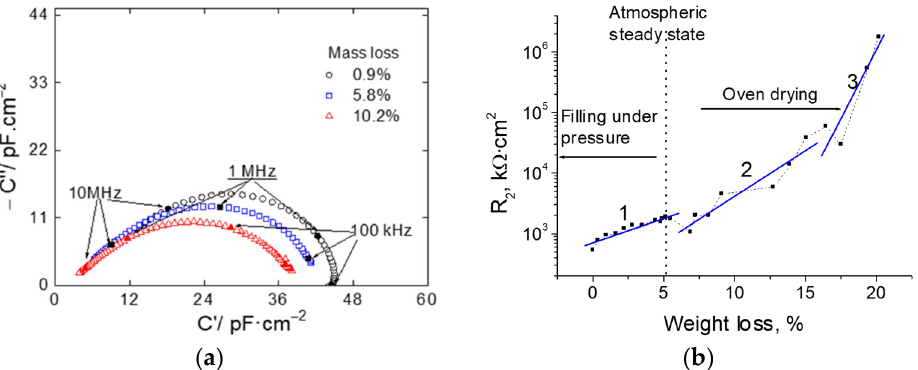
Figure 8. ( a ) Cole–Cole plot showing the dependence of the low ‐ frequency capacitance limit with the water content of a cement paste sample. ( b ) Evolution of the R 2 resistance with the sample’s water content. Figures taken from [29].